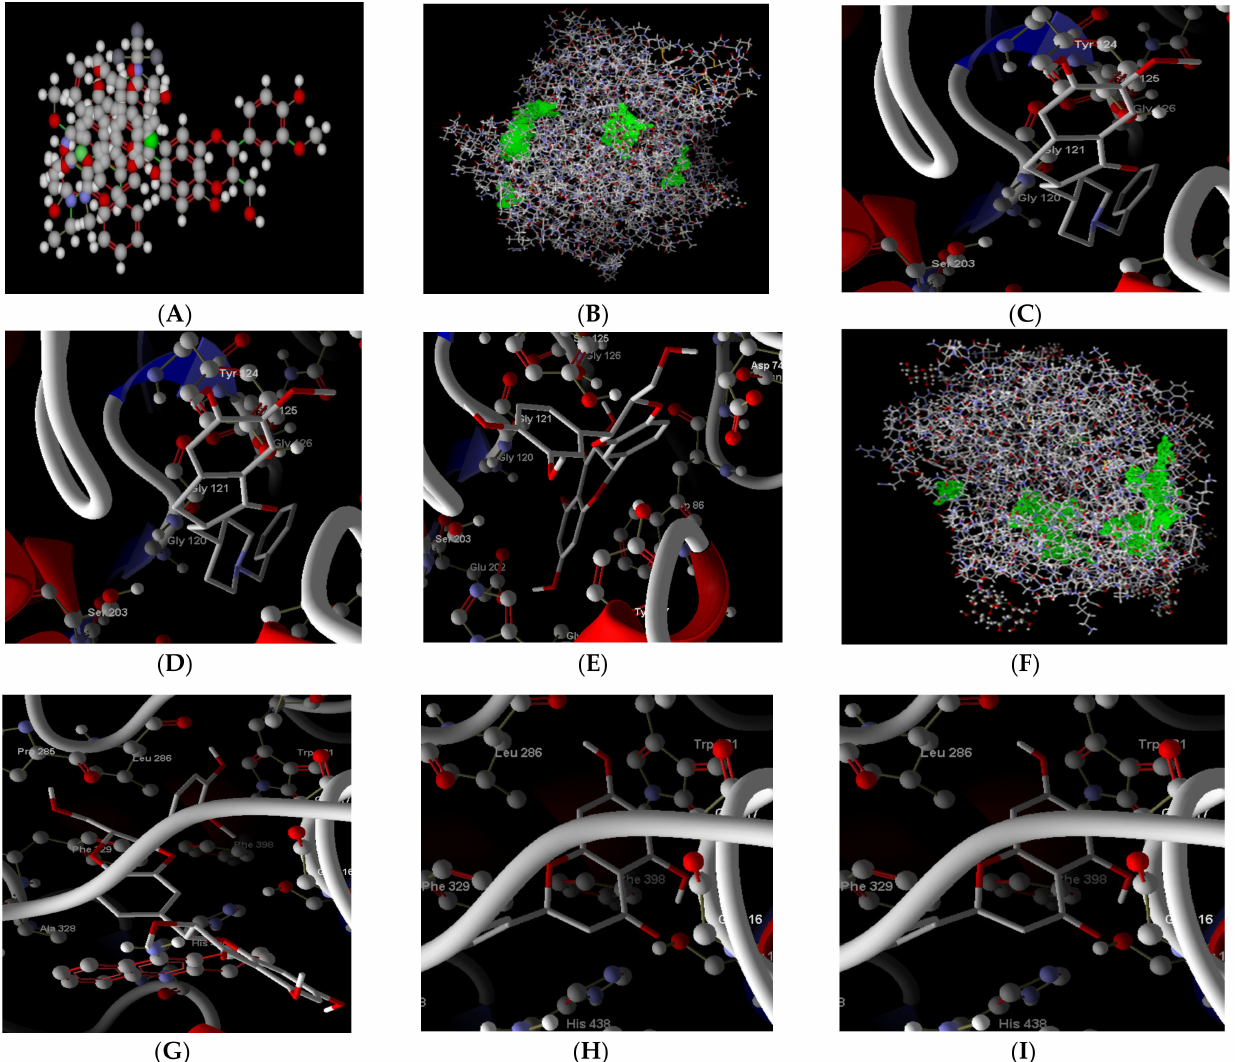
Figure 6. ( A ) Ligands in the workspace of MVD. ( B ) Crystal structure of AChE complex that binds to ligand in the cavity (green). ( C ) Donepezil docked with AChE. ( D ) Silibinin docked with AChE. ( E ) Naringenin docked with AChE. ( F ) Crystal structure of BChE complex that binds to ligand in the cavity (green). ( G ) Rivastigmine docked with BChE. ( H ) Silibinin docked with BChE. ( I ) Naringenin docked with